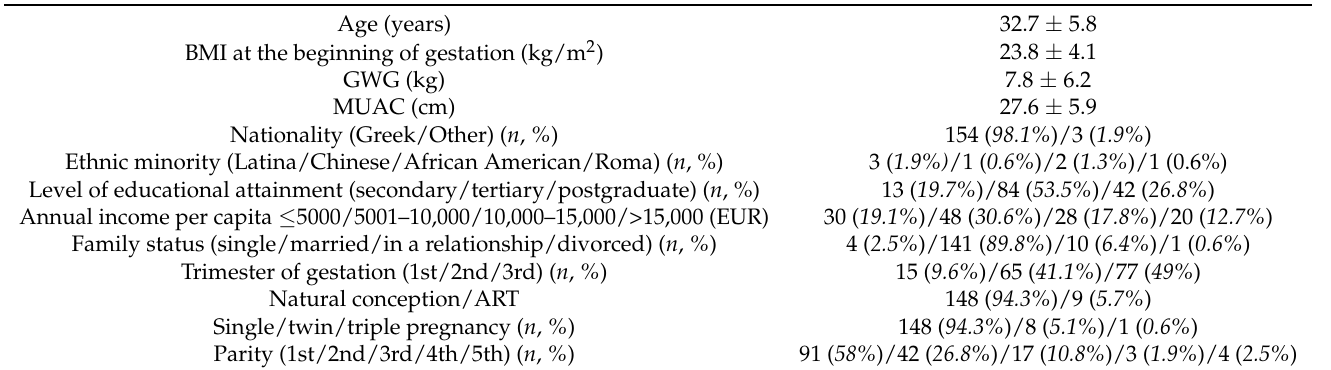
Table 1. Characteristics of the participating women (mean ± SD or n and % ) (N = 157). Age